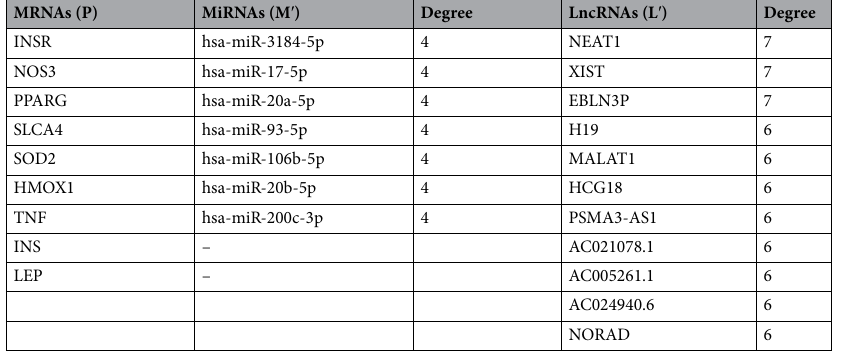
Table 1. Selected mRNAs, miRNAs and lncRNAs. Significant mRNAs, miRNAs, and lncRNAs are summarized in Table 1. No interacting miRNAs have been reported in the existing databases for INS and LEP among the 9 mRNAs. The hub miRNAs and lncRNAs are shown in columns 2 and 4, and the associated degrees of the intended miRNAs and lncRNAs are shown in columns 3 and